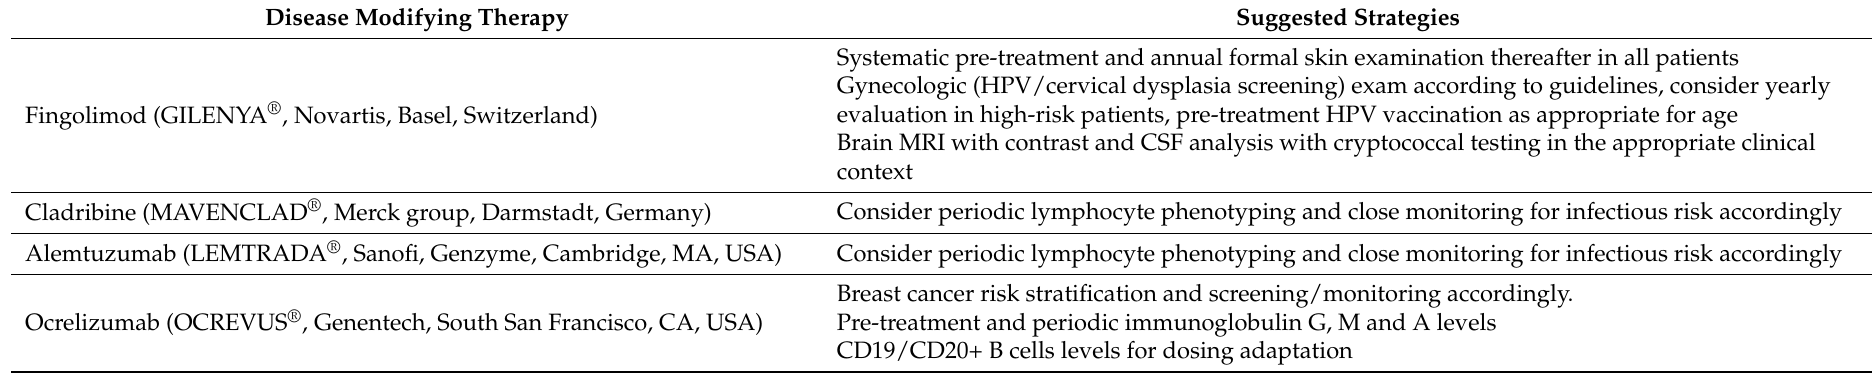
Table 3. Suggested additional monitoring strategies with newer disease modifying